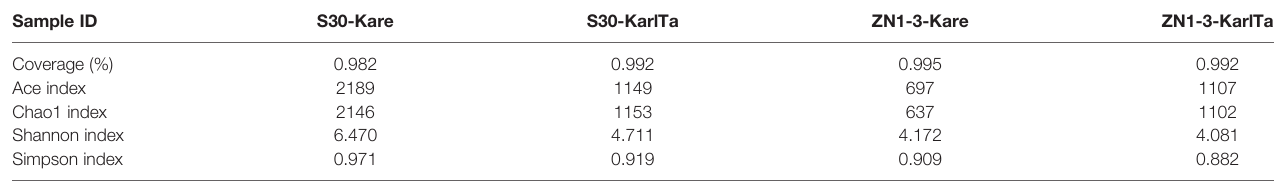
TABLE 9 | Results of the diversity analysis of samples from the SCS. Sample